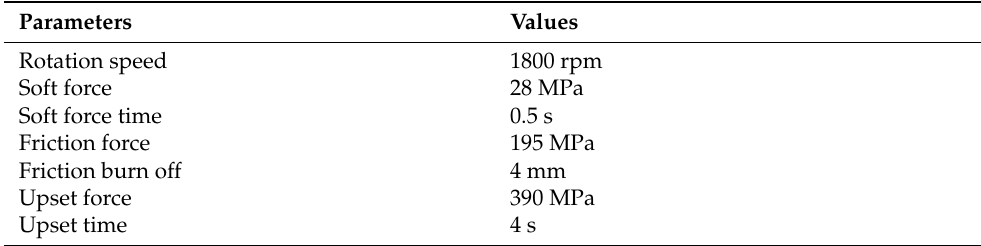
Table 2. Optimum welding parameters used to fabricate the joint.